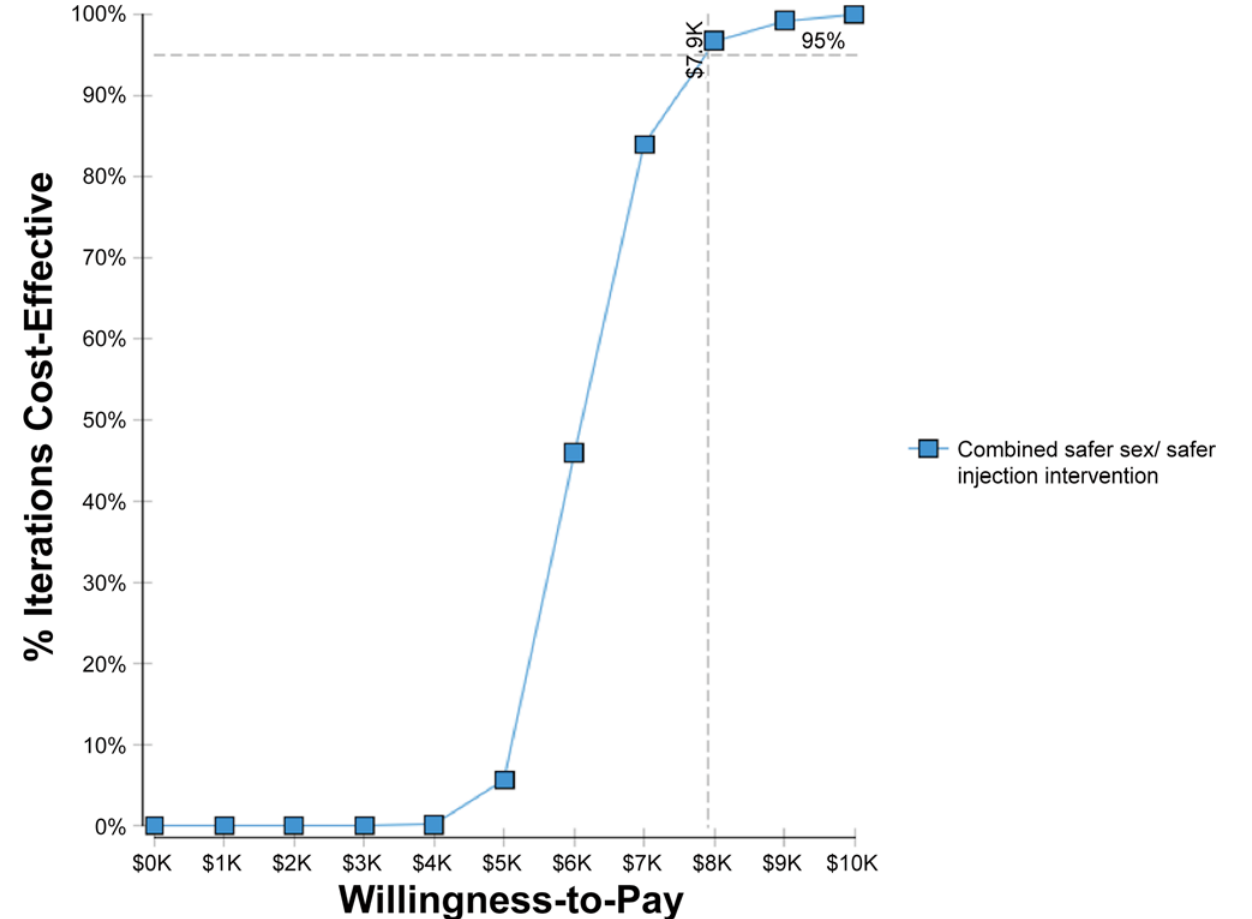
Fig 3. Cost-effectiveness acceptability curve for the combined interactive safer sex/Safer injection intervention for Ciudad Juarez.